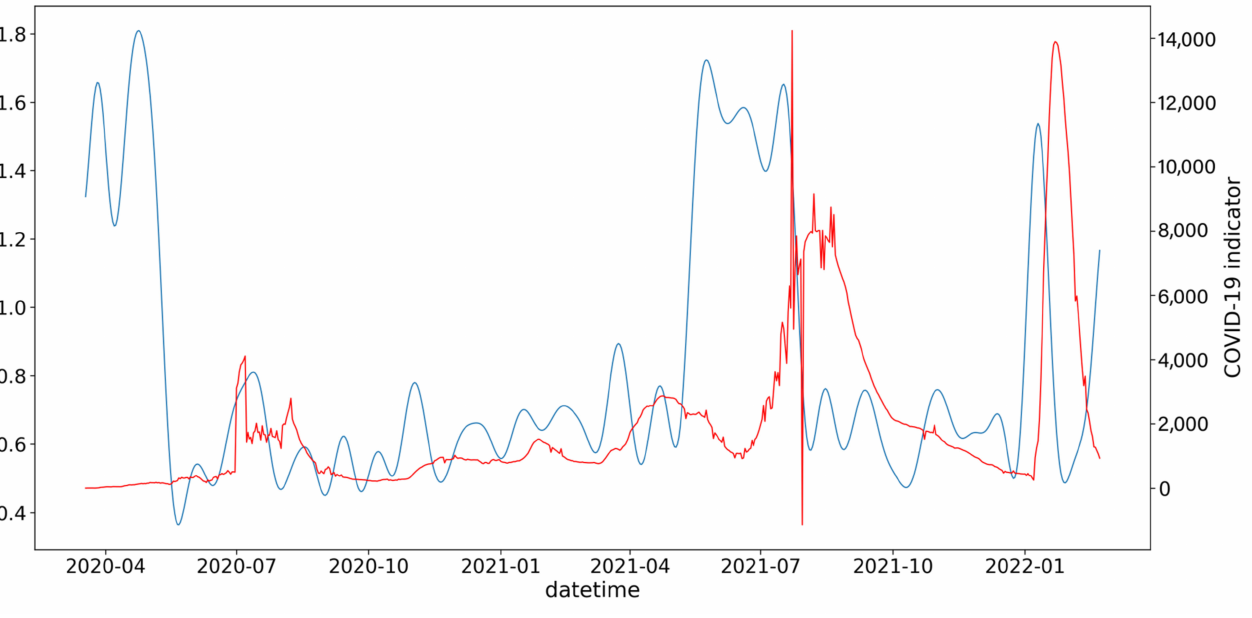
Figure 8. The red line represents the new cases of COVID-19, and the blue line represents the dynamics of the publication activity on topic “Fake, false information,